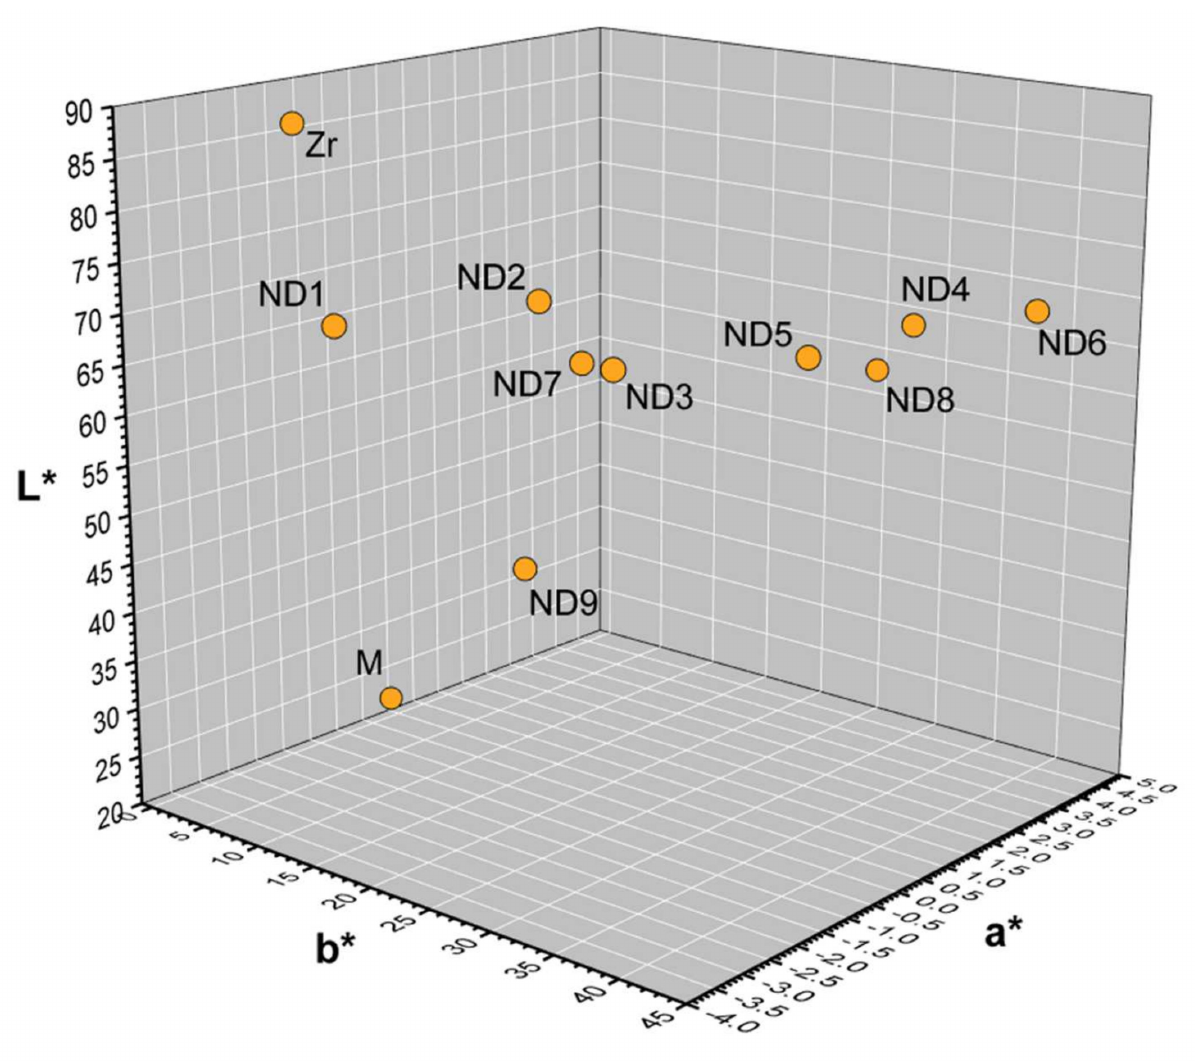
Figure 5. Mean CIELAB values of the eleven